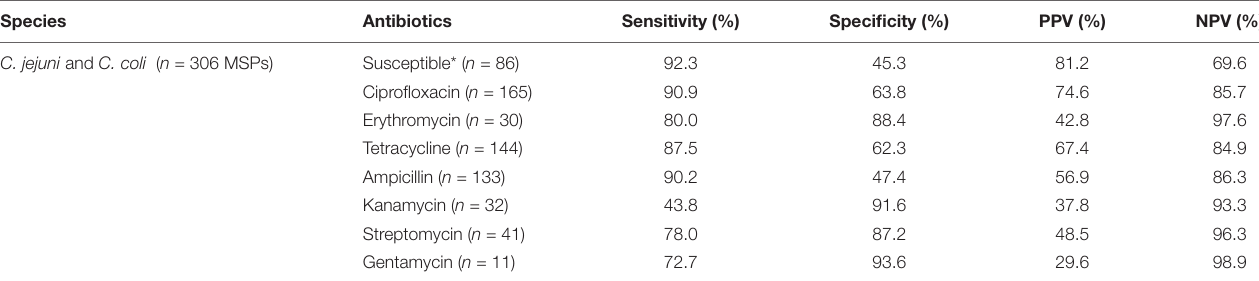
TABLE 2 | Performance of retained machine learning classifier using combined C. jejuni and C. coli MALDI-TOF main protein spectra profiles (MSPs) of the test set (30%, n = 306 MSPs), grouped by the resistance profile. Species Antibiotics Sensitivity (%) Specificity (%) PPV (%) NPV (%) C. jejuni and C. coli ( n = 306 MSPs)